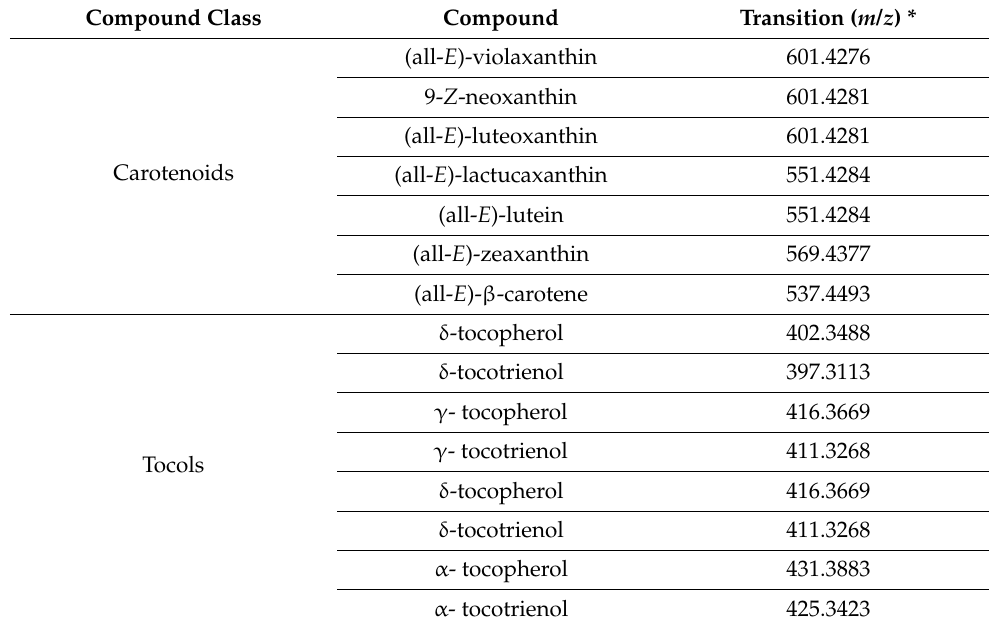
Table 2. The transition ( m / z ) utilized for selected ion monitoring (SIM) of carotenoids and